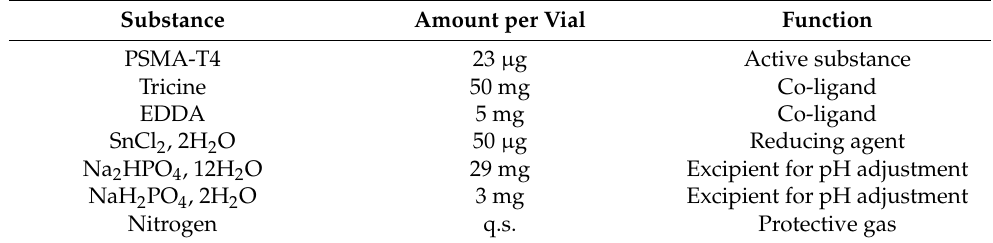
Table 9. Final kit composition of the PSMA-T4 for radiopharmaceutical